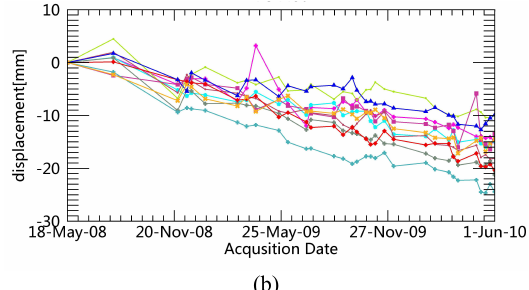
Figure 9. LOS displacement time series of the 10 chosen PS points (a) Nearby benchmark A; (b)Nearby benchmark B